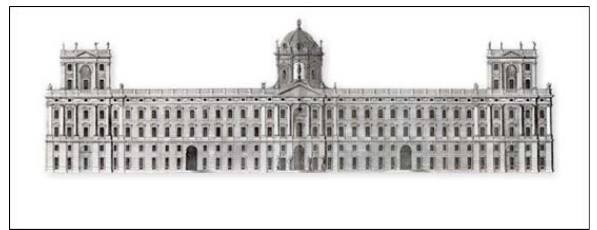
Figure 4. Statement of the original design of the building